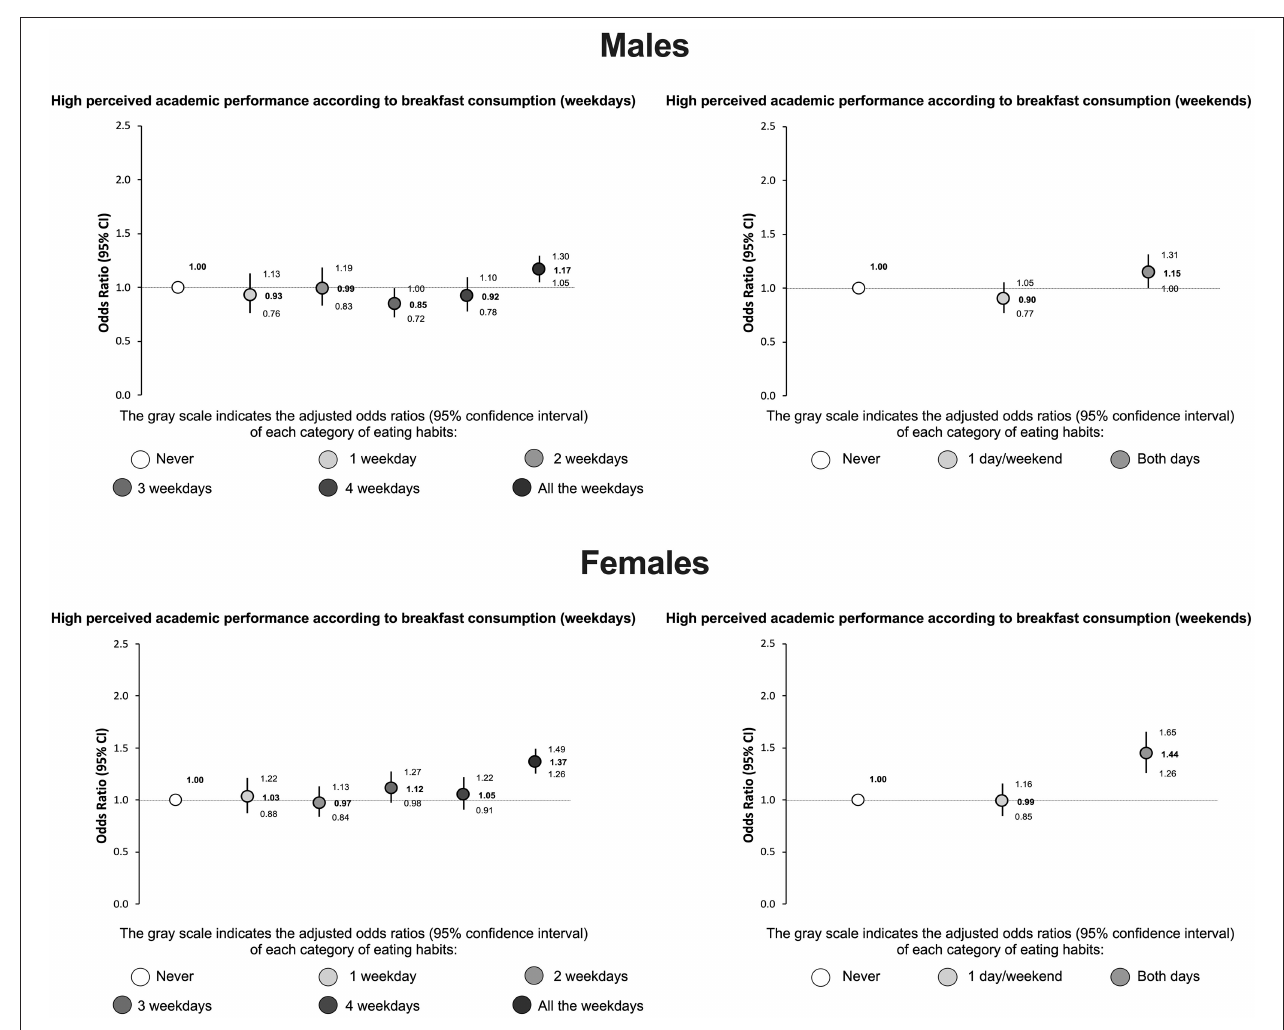
FIGURE 2 | Association between high perceived academic performance and breakfast consumption (on both weekdays and weekends) among adolescents. Odds ratios generated using logistic regression models adjusted by region, age, body mass index (z-score), socioeconomic status, physical activity, recreational screen time, and sleep